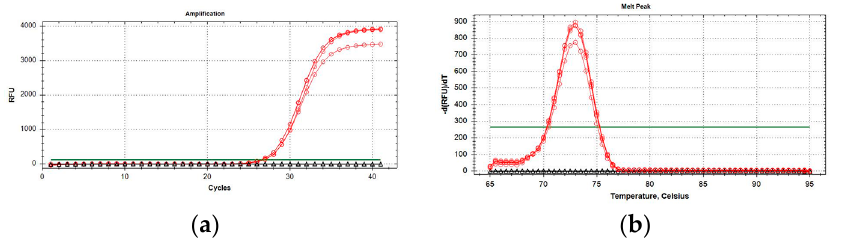
Figure 2. Amplification curves ( a ) and melting peaks ( b ) of P. italosignus adults (red circles). Black triangles: adults of N. campestris and P. spumarius